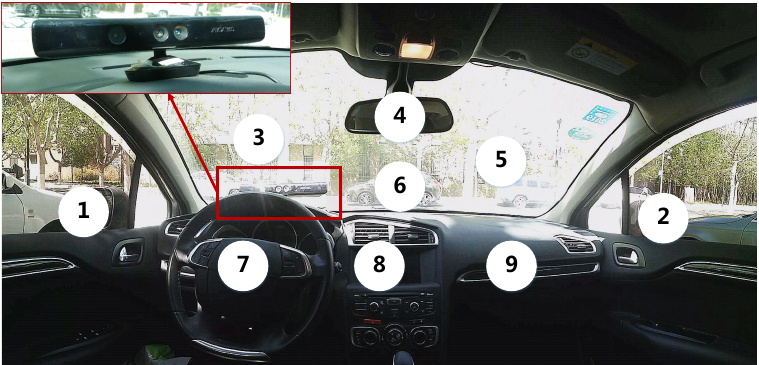
Figure 8. Driver gaze zone partition in real driving